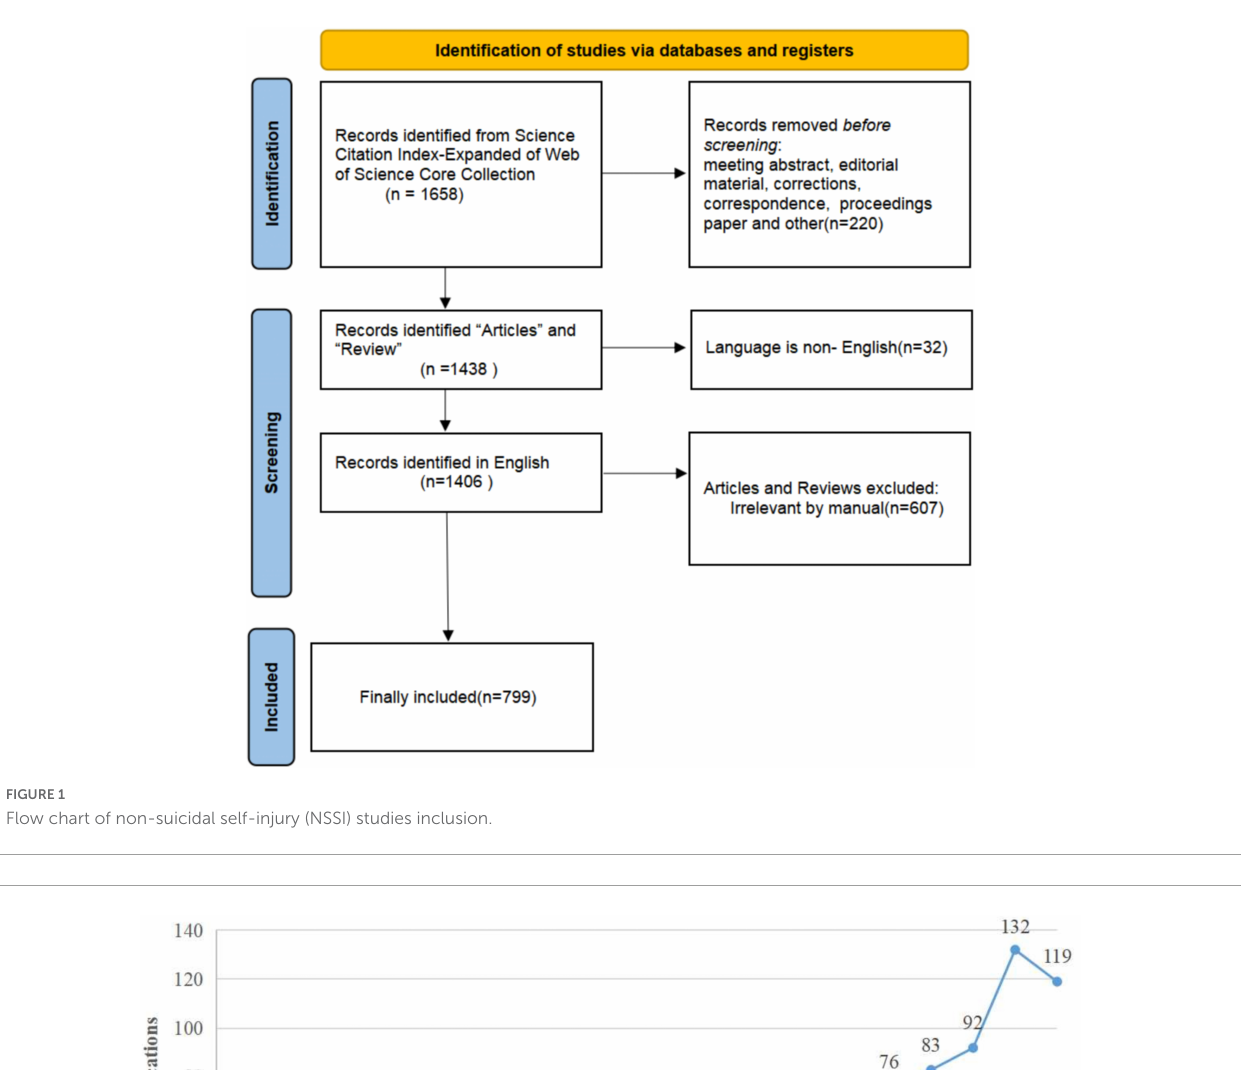
FIGURE1 Flow chart of non-suicidal self-injury (NSSI) studies inclusion.